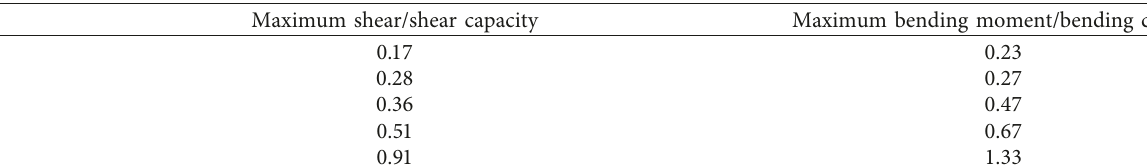
Table 6: Response of force of brake pier for the five cases.